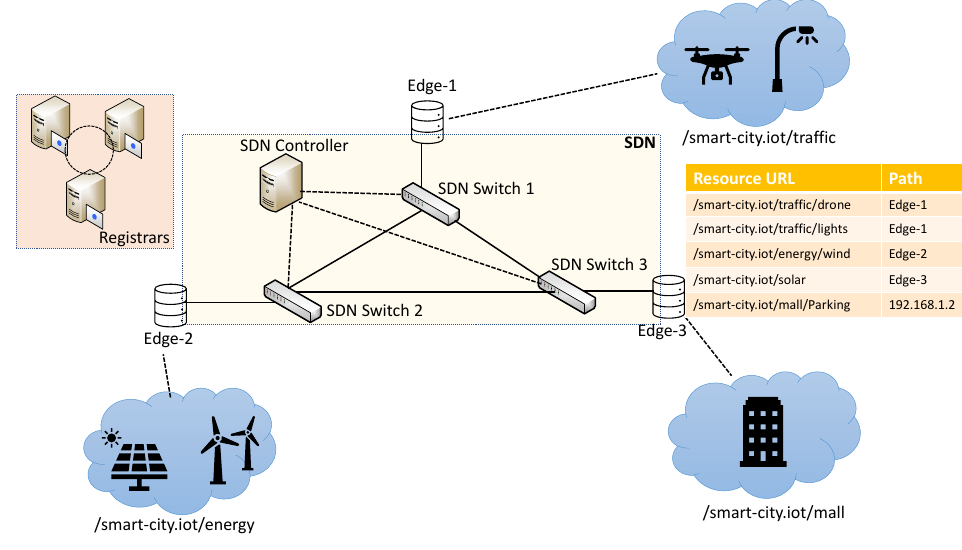
Figure 1. System